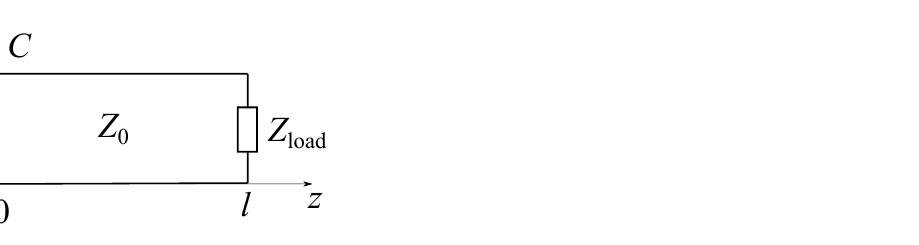
Figure A1. Electrical equivalent circuit of the resonator including a capacitor and a section of a transmission